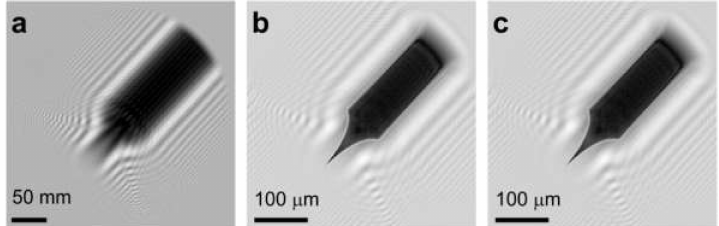
Figure 19. Optical hologram of a tungsten tip and its reconstruction. ( a ) Hologram recorded with 532 nm laser light in an in-line Gabor scheme with spherical waves, with a source-to-sample distance of 1.4 mm, and a source-to-screen distance of 1060 mm. ( b ) Amplitude of the object distribution reconstructed from the hologram shown in ( a ) using the reconstruction algorithm for spherical waves, where the size of the reconstructed area is 429 × 429 µ m 2 . ( c ) Amplitude of the object distribution from the hologram shown in ( a ) using the reconstruction algorithm for plane waves, assuming a hologram size of 429 × 429 µ m 2 and a sample-to-hologram distance of 1.4 mm. Adapted from